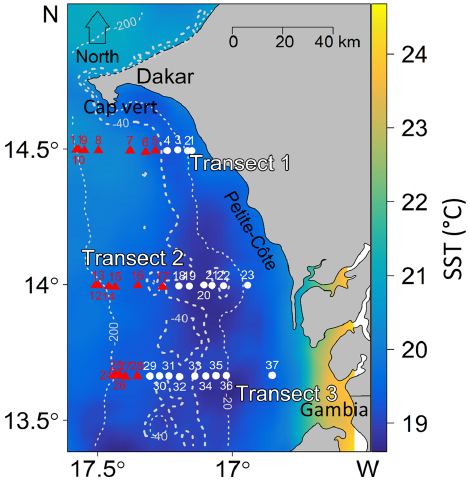
Figure 1. Location of the survey area off the southern Senegalese (West African) coast. The hydroacoustic survey was conducted with FRV Antea (IRD) from Dakar (Cap-Vert peninsula) to the northern border of Gambia. CTD probes collected data at stations along three transects perpendicular to the coast (T1 to T3). Sea surface temper- atures (SST, ◦ C) were averaged over the 3d of CTD sampling from the 6 to 8 March 2013. Stations of Group 1 (white circles) were located in the inshore zone, whereas stations of Group 2 (red trian- gles) were situated further offshore. The dashed white lines repre- sent bathymetry (in